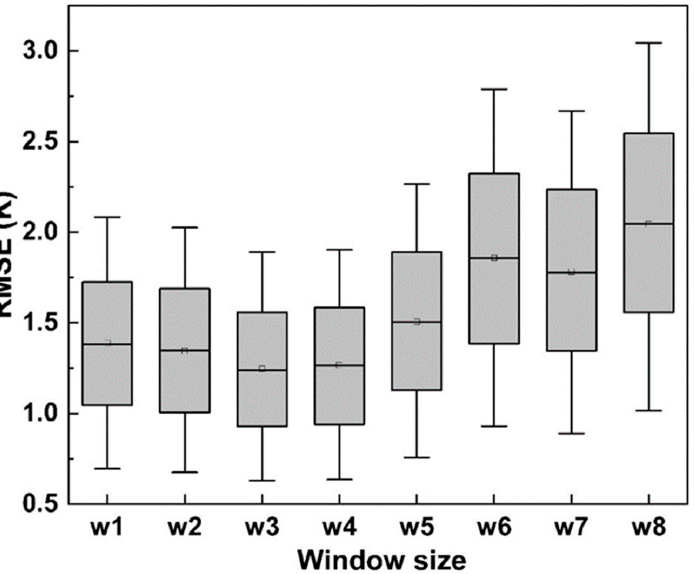
Figure A1. The accuracy of the ATC_GL along with the increase in the size of the initial spatial window. w1–w8 denote the size of 5 × 5, 7 × 7, 9 × 9, 11 × 11, 13 × 13, 15 × 15, 17 × 17, and 19 × 19 pixels of initial spatial window, respectively.